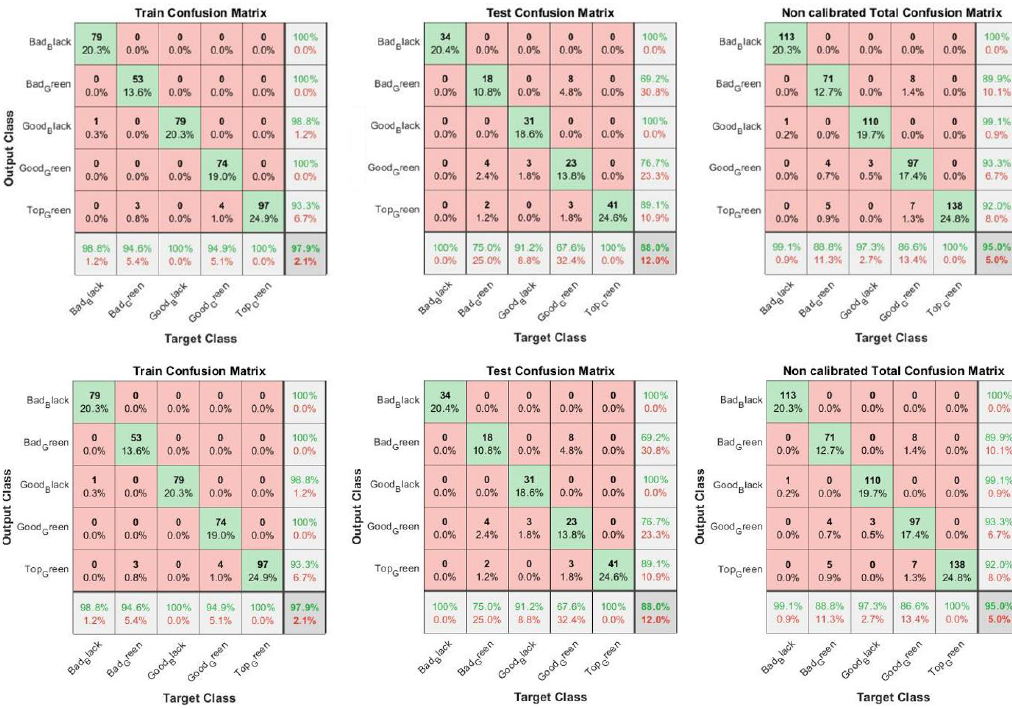
Figure 6. Confusion matrices for training, test and overall non-calibrated data sets. The off-diagonal elements of these matrices show the number of false positive ( up right ) and false negative ( down left ) cases.